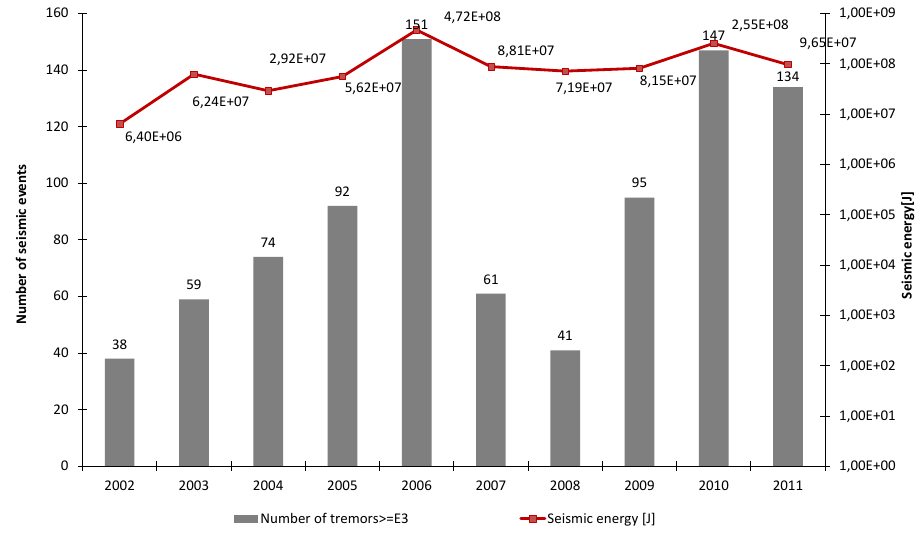
Figure 3. Seismic activity for the period of 2002 – 2011 in the analyzed field [13].